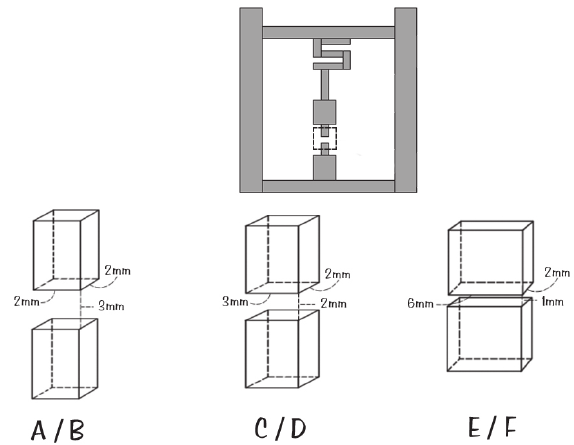
Figure 1- Schematic aspect of steel bases dimensions of all